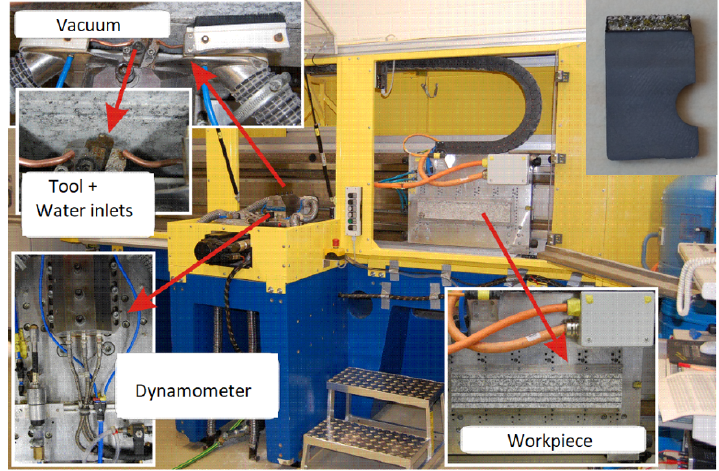
Figure 4. Linear test rig at TFF [3] and wire-eroded single segment of the galvanic diamond bandsaw blade.